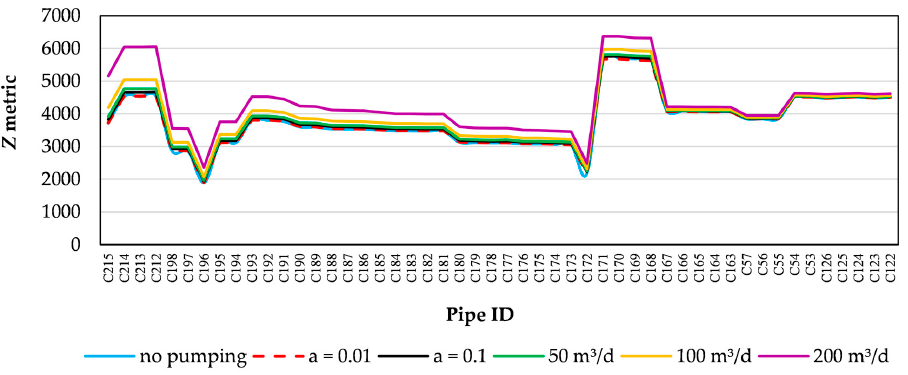
Figure 14. Values of the Z metric across the optimal pipe path of area ID 3 with respect to several pumping scenarios. The results shown in this figure concern a specific loading scenario with moderate